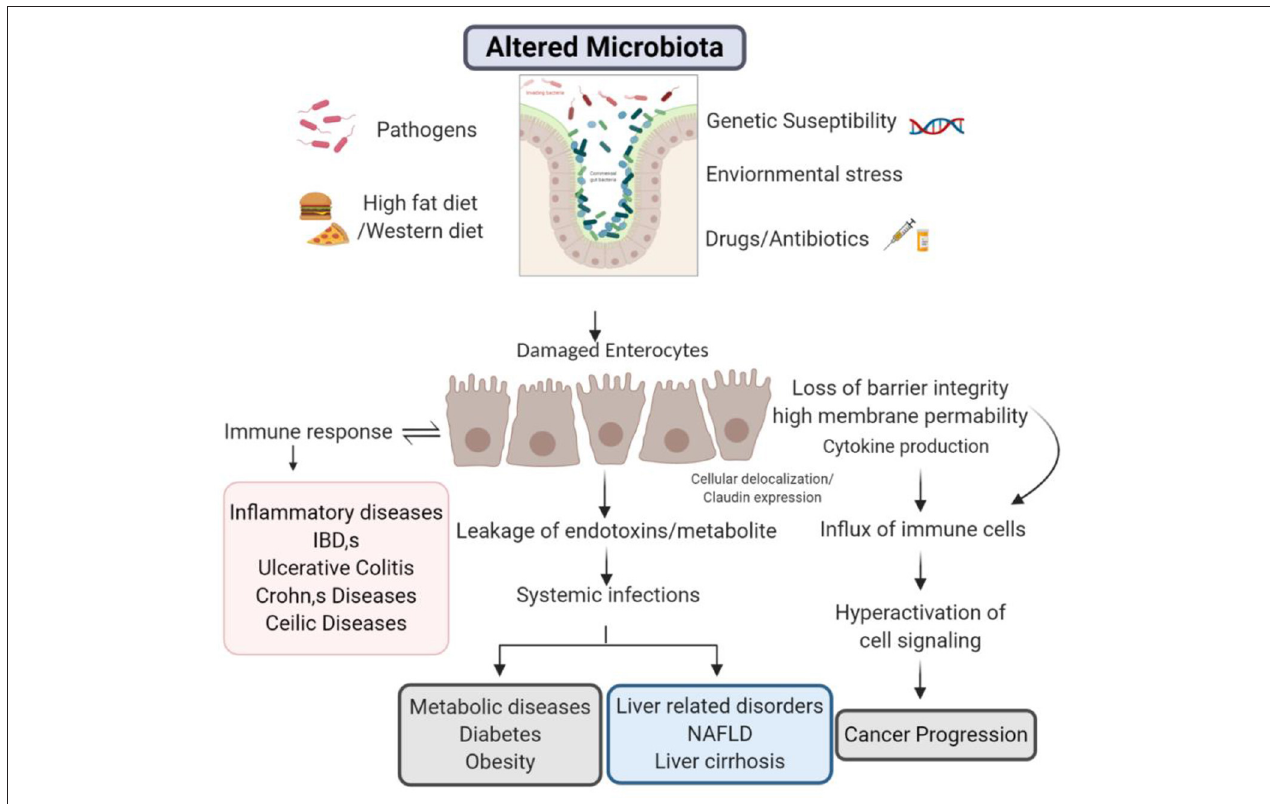
FIGURE 2 | Barrier integrity during diseased